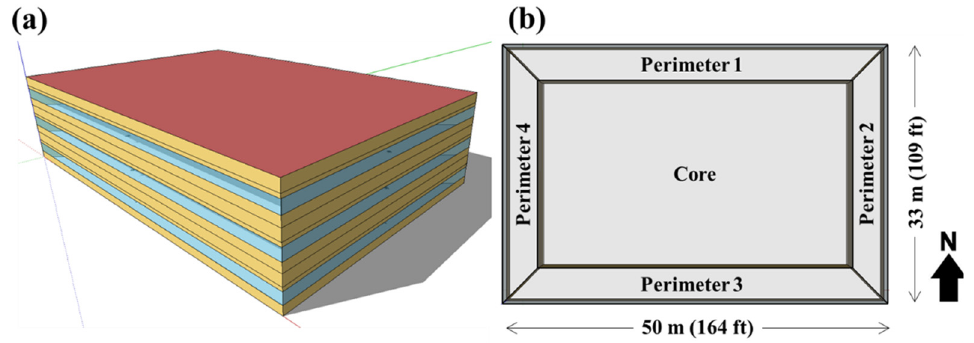
Figure 5. Medium office building model: ( a ) 3D view and ( b ) floor plan [8].